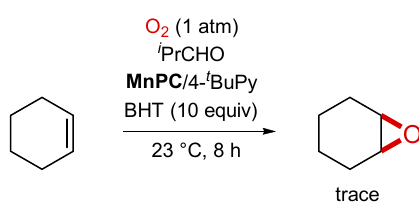
( b ) Figure 2. In situ UV-vis spectra of the manganese porphyrin cage catalyst MnPC during the aerobic